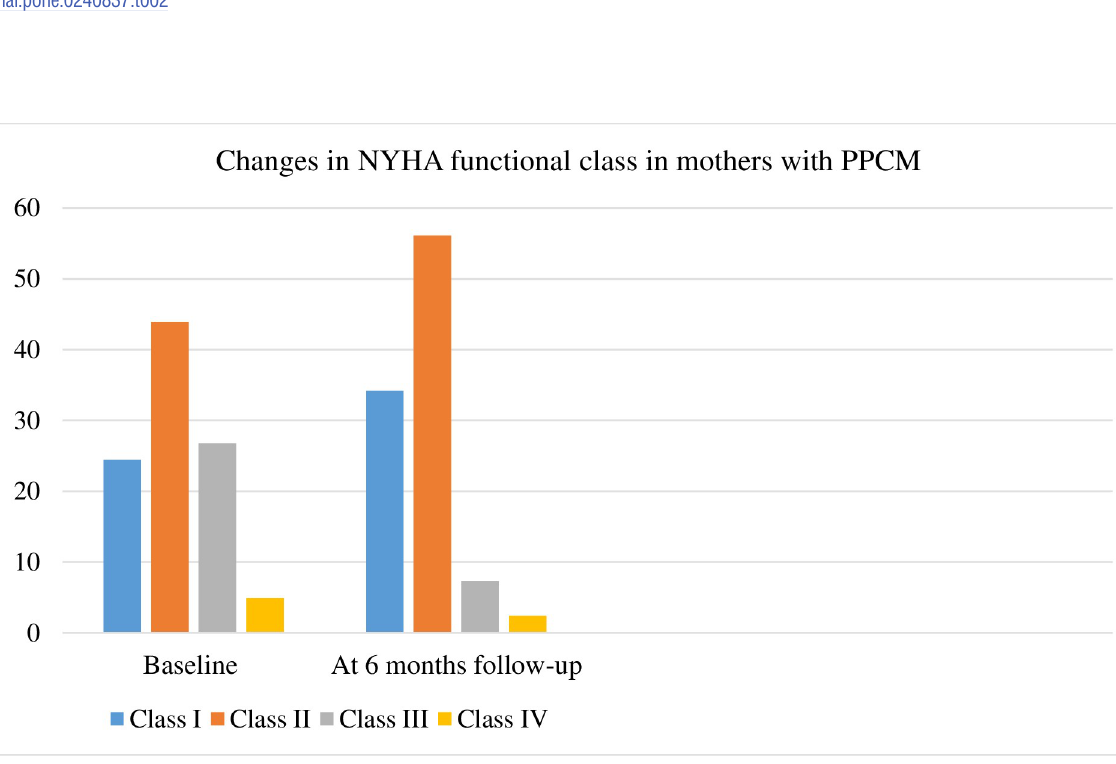
Fig 1. Changes in the New York Heart Association (NYHA) functional class in mothers with